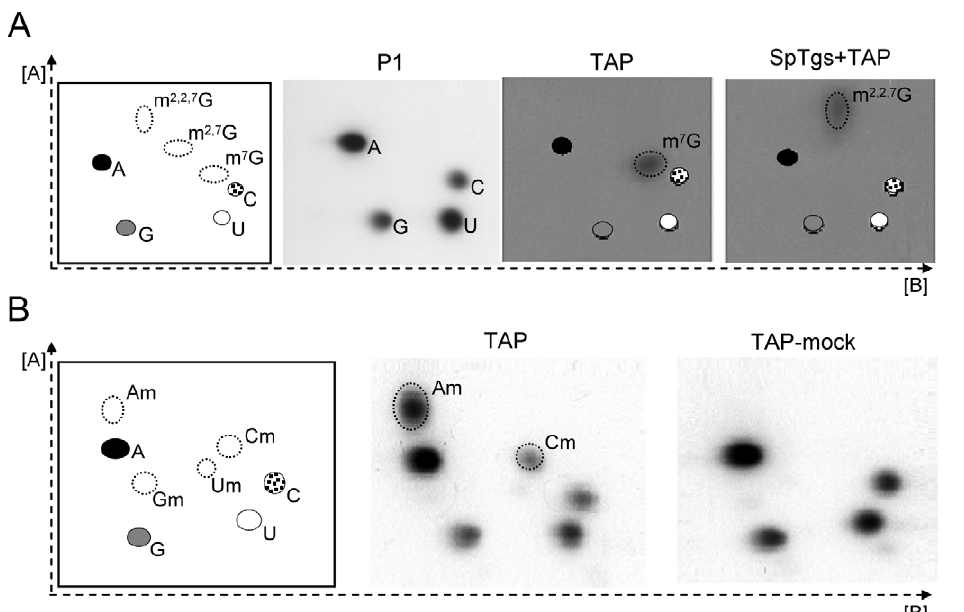
Figure 6. Detection of cap 0 and cap 1 modified nucleotides on T.vaginalis mRNA by 2D-TLC analysis. A. Detection of cap 0 modified nucleotide using in vivo 32 P-labeled mRNA. The predicted migration of unmodified ribonucleotides (A, C, G and U) are shown in all panels for reference and left panel also denote modified ribonucleotide standards migration (dotted ovals). P1 =nuclease P1 digestion; TAP =TAP treatment; SpTgs + TAP =SpTgs incubation prior to TAP treatment. B. Detection of cap 1-modified nucleotide. Unlabeled T. vaginalis mRNA either TAP treated ( TAP ) or mock-treated ( TAP-mock ) subjected to 5 9 -end labeling, nuclease P1 digestion and resolution on 2D-TLC.